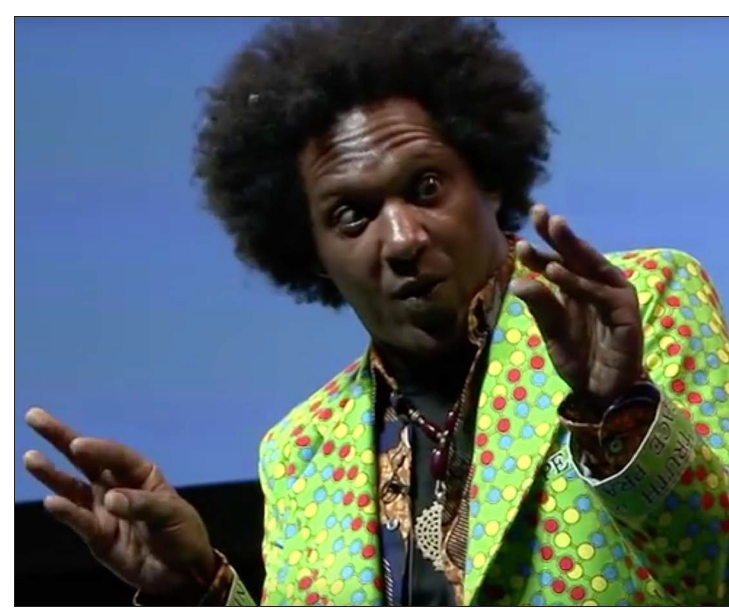
Figure 3: ‘Morning Breaks: Lemn Sissay at TedX Salford’ [11:46]